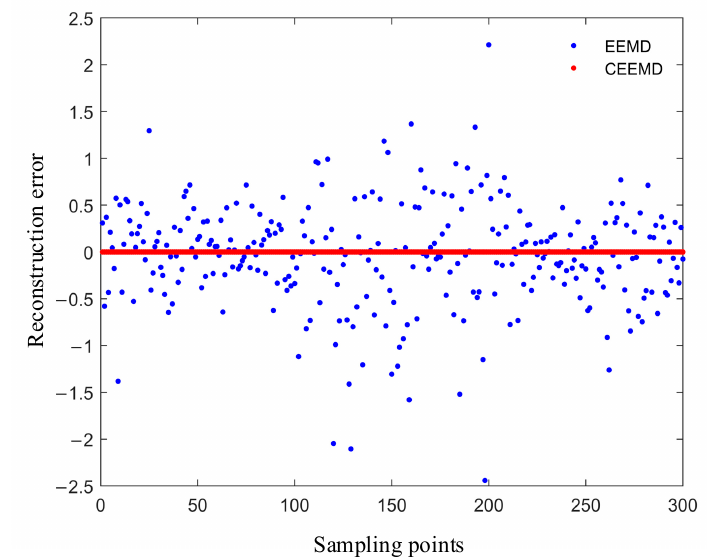
Figure 10. Reconstruction error of EEMD and CEEMD.